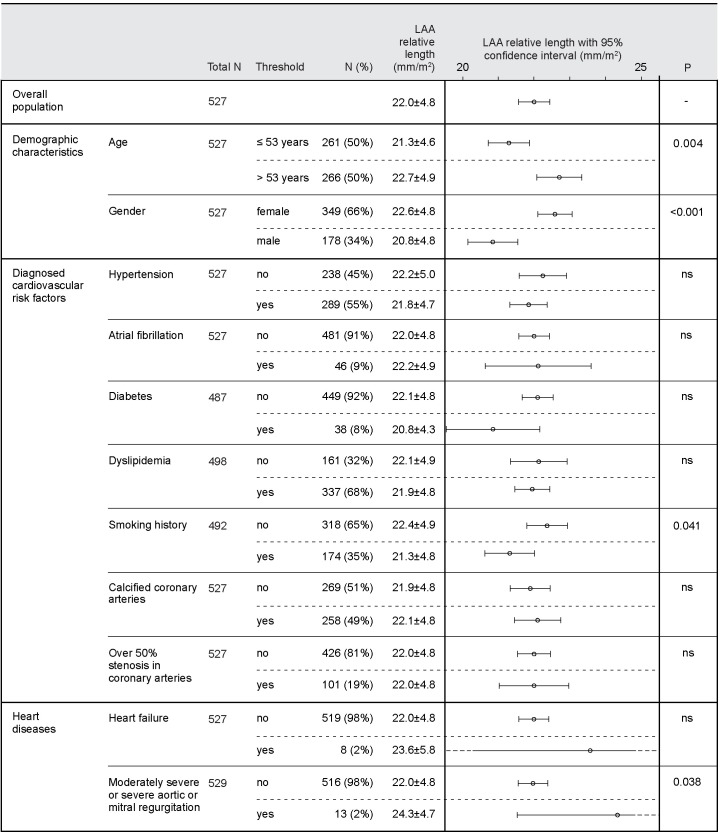
Correlates between relative left atrial appendage length and classification criteria.